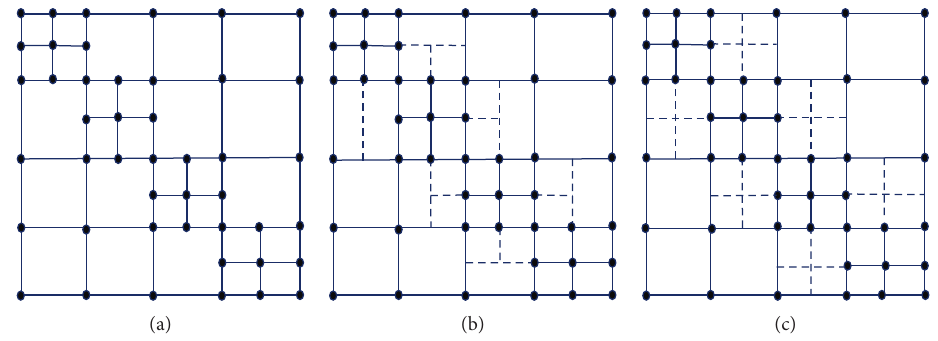
Figure 2: A design-suitable T-mesh and the p-extending. (a) Diagonal T-mesh, (b) p-extending, and (c) full-extension T-mesh.